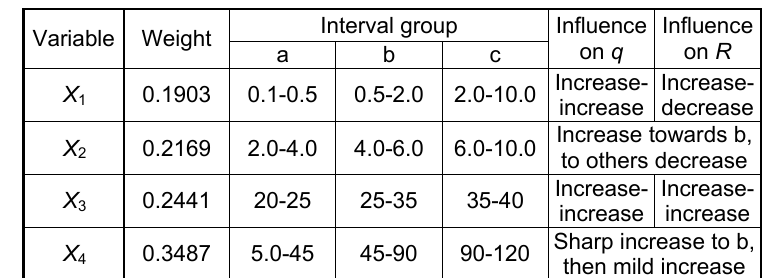
Table 2 – Weights of the input FLS variables and their influence on the output